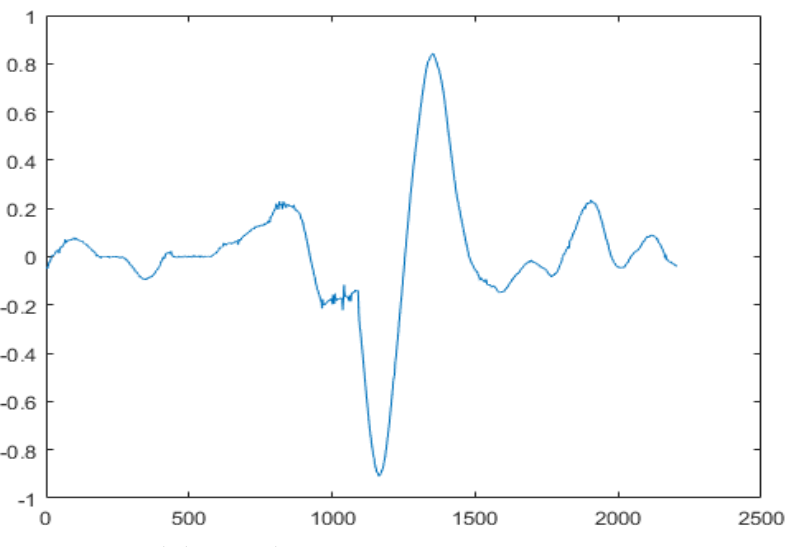
Figure 4. A single heart cycle